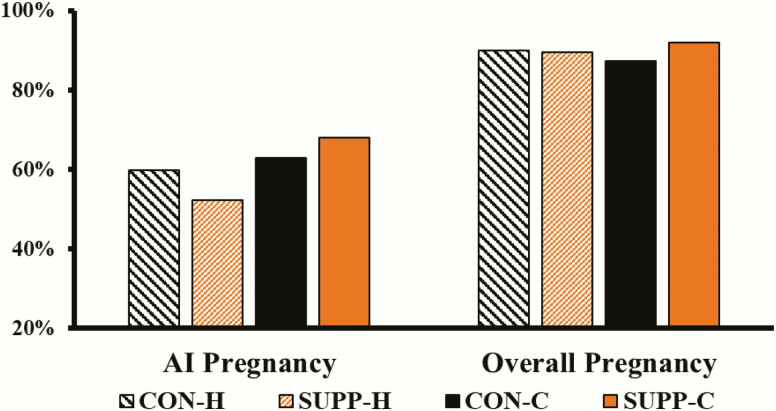
Reproductive performance (AI pregnancy rate and overall pregnancy rate) of four treatment combinations (n = 8 groups per treatment combination): yearling heifers receiving no supplement (CON-H); yearling heifers receiving supplement of dry-rolled corn (SUPP-H; 1.81 kg as-fed/heifer/d) for 42 d; 2-yr-old lactating cow-calf pairs receiving no supplement (CON-C); and 2-yr-old lactating cow-calf pairs receiving supplement of dry-rolled corn (SUPP-C; 1.81 kg as-fed/cow/d) for 42 d from the end of April through early June in 2017 and 2018. Supplementation × age and supplementation effects were not detected (P ≥ 0.25) for AI or overall pregnancy rate percentage. Age tended (P = 0.07) to affect AI pregnancy rate, but not affect (P = 0.98) overall pregnancy rates.